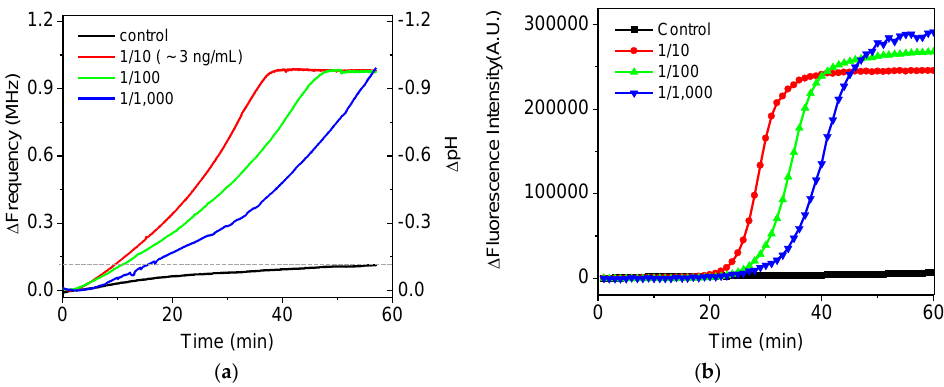
Figure 7. ( a ) In situ frequency and pH variations of serially-diluted samples during isothermal amplification. The dotted line shows the final frequency change of the control experiment. ( b ) Variations in the fluorescence intensity of the serially-diluted samples during the isothermal amplifications using a commercial PCR device.